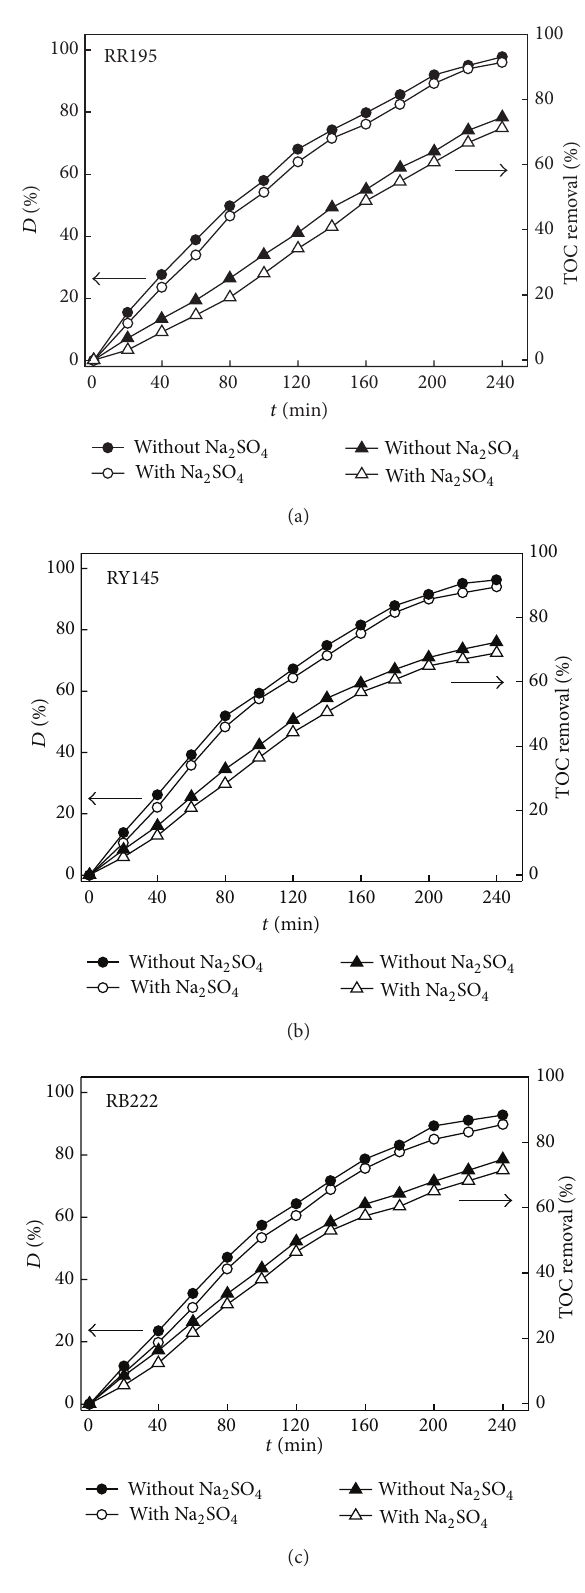
Figure 4: Effect of Na 2 SO 4 on degradation of three reactive dyes ([dye] = 0.05 mmolL −1 , [H 2 O 2 ] = 6.0 mmolL −1 , catalyst = 5.0 gL −1 , [Na 2 SO 4 ] = 10.05gL −1 , pH =